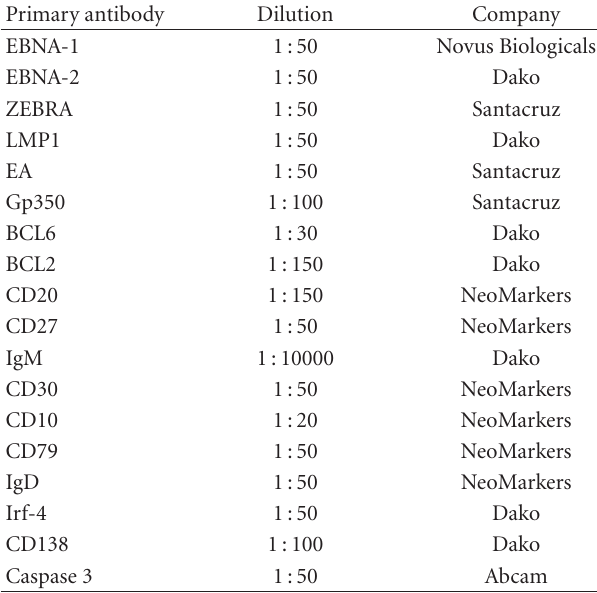
Table 1: List of antibodies and their respective concentrations. Primary